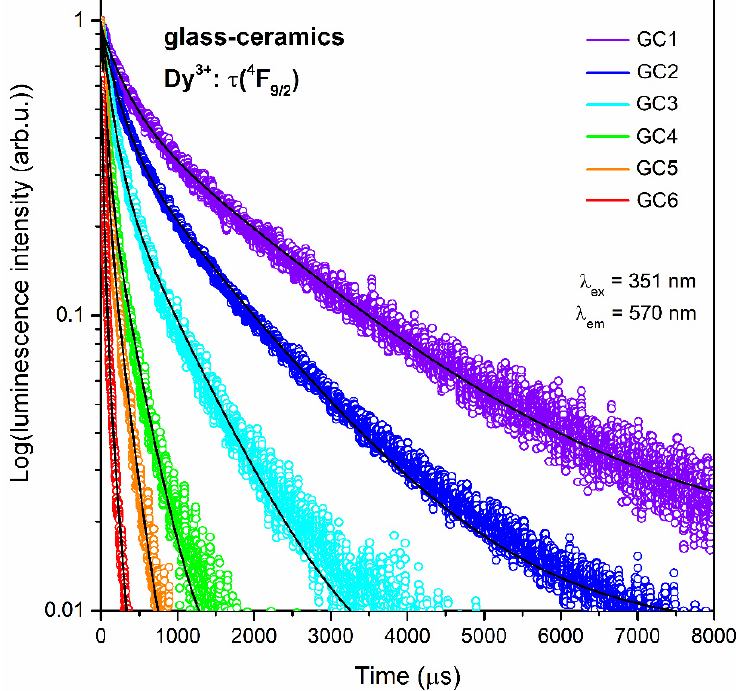
Figure 10. Luminescence decay curves recorded for the 4 F 9/2 state of Dy 3+ ions for SiO 2 -LaF 3 nano-glass-ceramic materials ( λ ex = 351 nm, λ em = 570 nm). Table 6. Decay components ( τ n ), residual weighting factors (A n ), and average decay times ( τ avg ) of